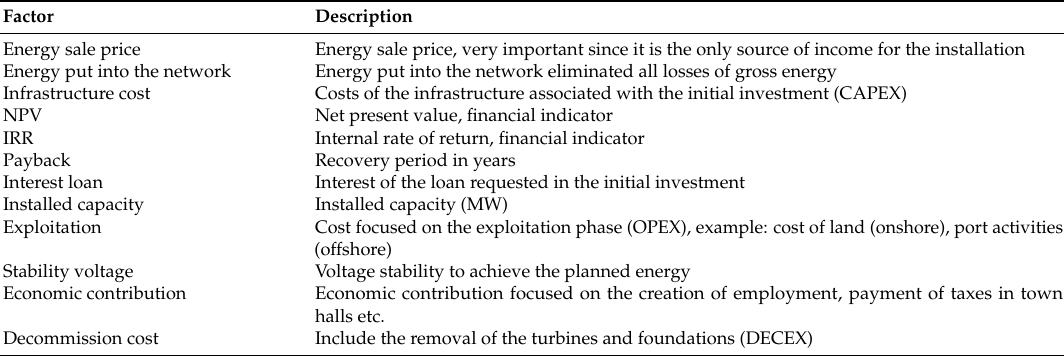
Table 5. Description of factors involved in the optimal location in the wind farms. Economic